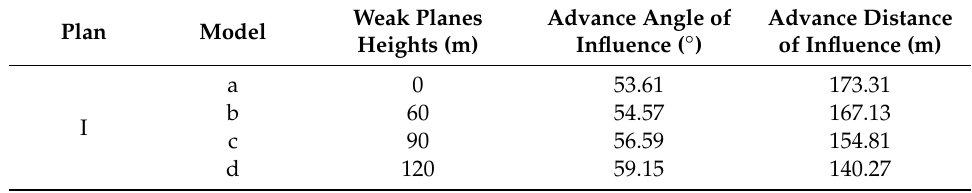
Table 2. Numerical simulation results of influence of weak planes heights on surface movement.